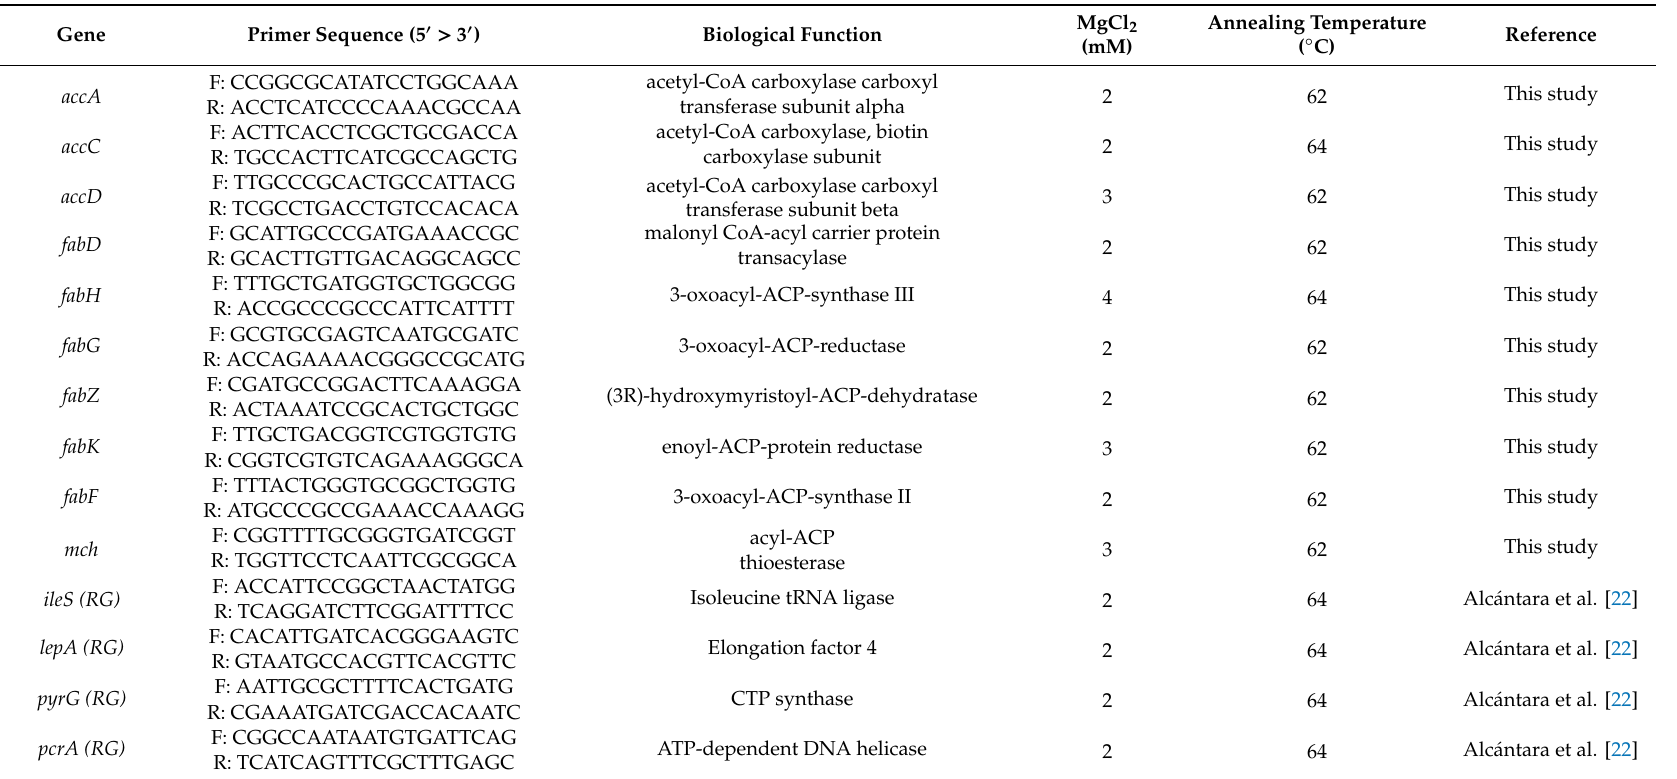
Table 1. Primers used in this work and their description in terms of function, annealing temperature, final concentrations of MgCl 2 and relative reference. ileS , lepA , pyrG , pcrA were tested as reference genes for the gene expression